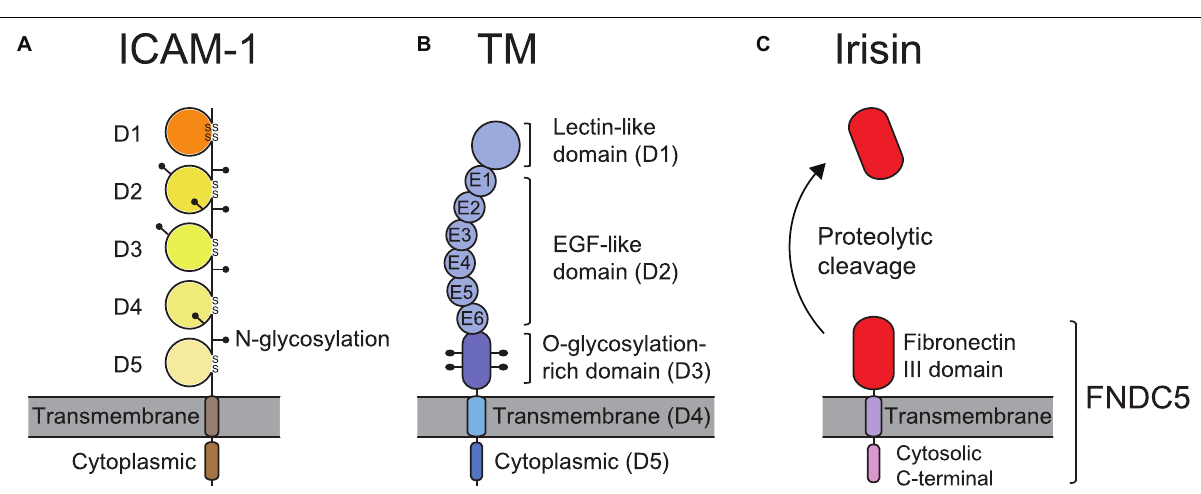
FIGURE 1 | Integrin domains and structures. Illustrations depict the extended conformation of integrins bearing the headpieces with high-affinity domains. Representative structures of α I domain-containing integrins (e.g., α L β 2) and -deficient integrins (e.g., α V β 5) are shown at left (A) and right (B) , respectively. The integrin α / β heterodimer is composed of multiple functional domains in extracellular (headpiece plus legpiece), transmembrane, and cytoplasmic portions. I-EGF, integrin-epidermal growth factor; and PSI, plexin/semaphorin/integrin.